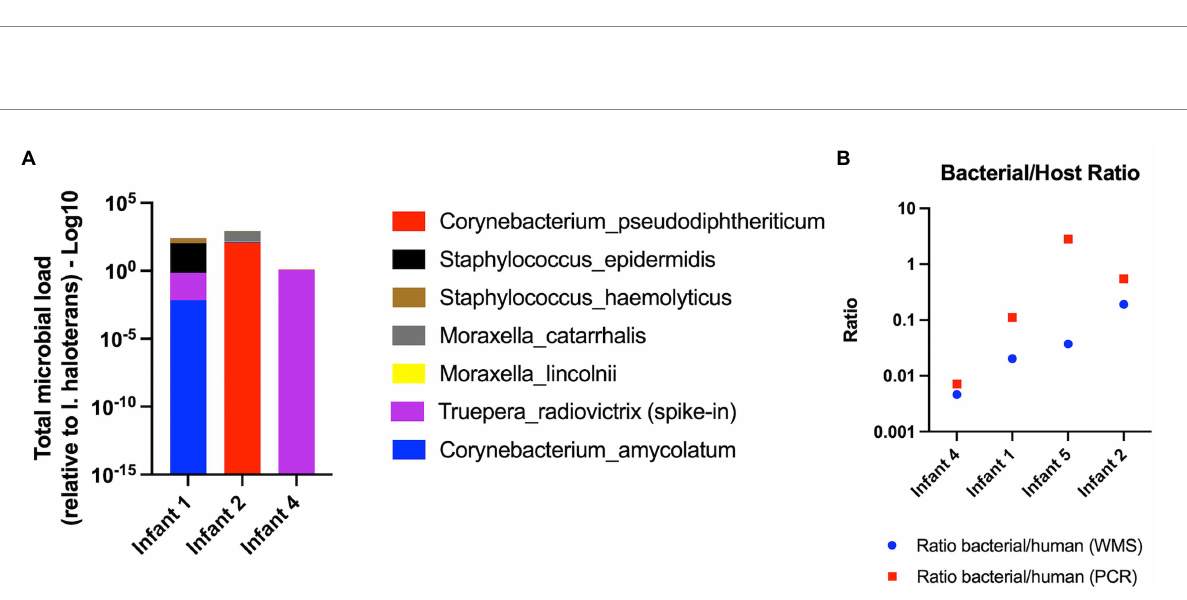
FIGURE 7 Rarefaction analysis of two samples with different host DNA content at two sequencing depths at mechanism, class, gene and allele levels, performed on remaining reads (after removal of host reads). Both samples were processed with Mol_MasterPure protocol. Host DNA content was 92% for the sample originating from pool B, and 15% for the sample originating from pool C. Number of total reads for sample from pool B processed with Mol_MasterPure protocol was 18 M (pink line) and 68 M (purple line). Number of reads assigned to bacteria was 0.7 M and 2.9 M, respectively. Number of total reads for sample from pool C processed with Mol_MasterPure was 15 M (pink line) and 68 M (purple line). Number of reads assigned to bacteria was 8.2 M and 27 M, respectively.